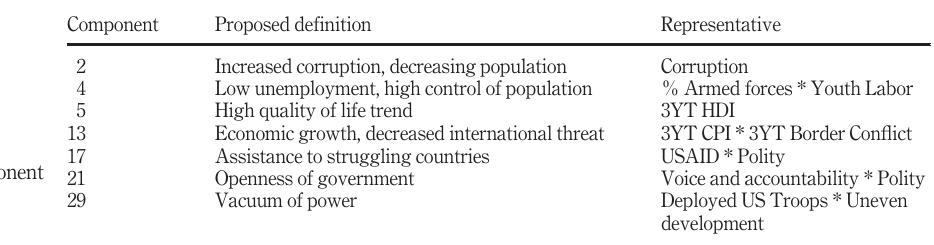
Table II. Principal component de fi nitions